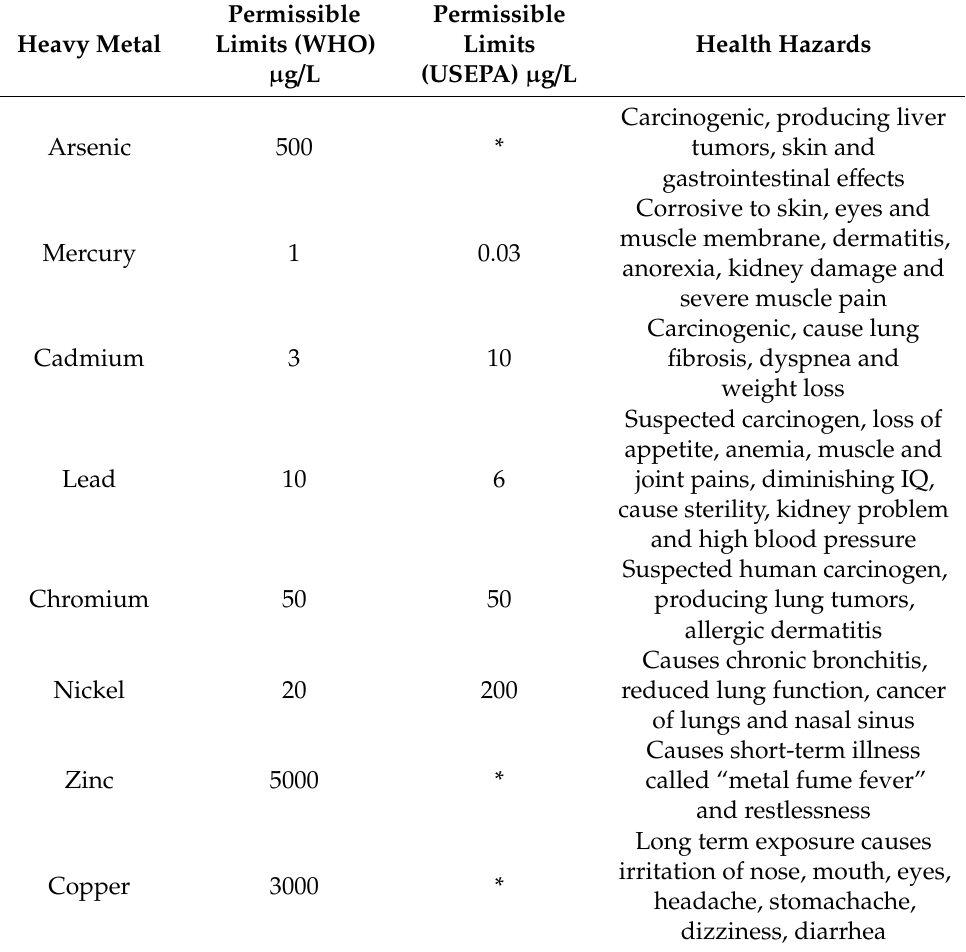
Table 1. Permissible limits for various heavy metals in wastewater treatment e ffl uents according to the World Health Organization [2] and United States Environmental Protection Agency (USEPA)